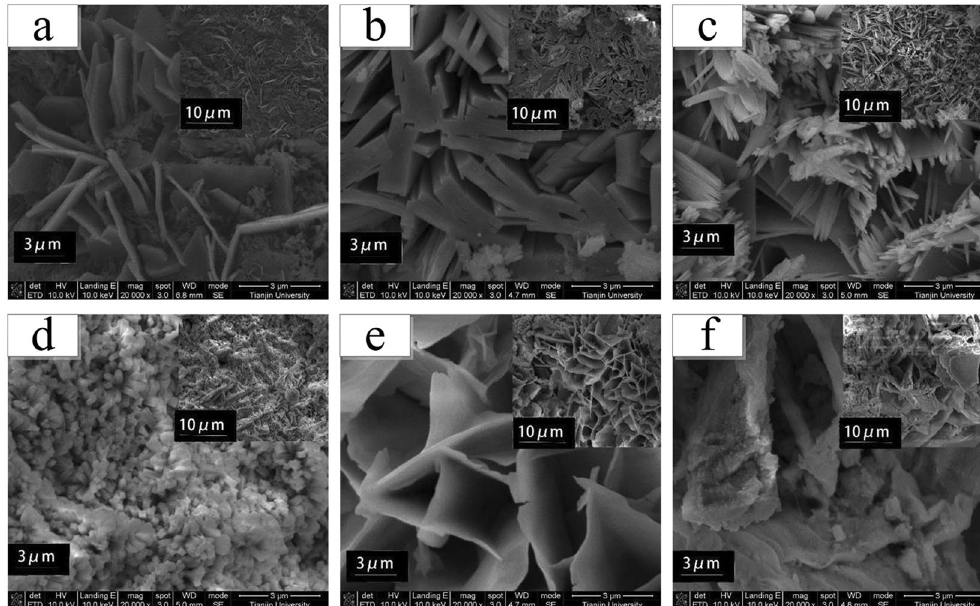
Figure 4. Rust surface of carbon steel coupons exposed to soils of different chloride concentrations i.e. ( a ) 0.015%, ( b ) 0.065%, ( c ) 0.115%, ( d ) 0.315%, ( e ) 0.515%, ( f ) 1.015% (wt.%) after 12 weeks.